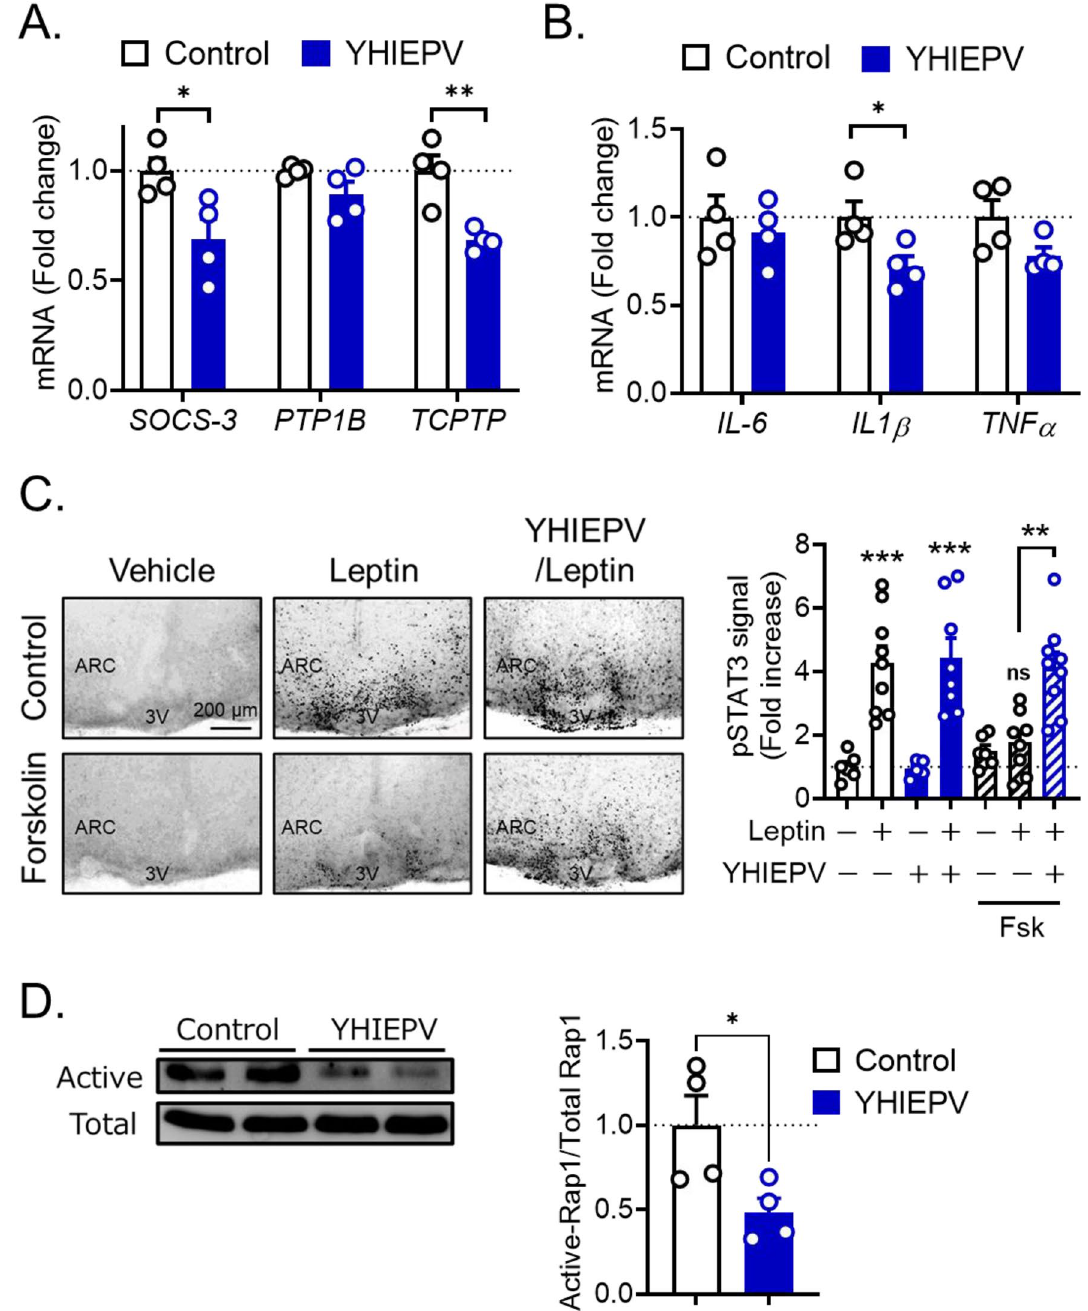
Figure 4. YHIEPV reduces central responses of proinflammatory-related factors and Rap1 activation. ( A , B ) Hypothalamic expression of genes involved in decreased leptin responsiveness in YHIEPV-treated and control C57BL/6 mice. The hypothalamus was collected from 4-month-old HFD-fed male mice after 5 days of the YHIEPV treatment (0.3 mg/kg, p.o.). YHIEPV reduced the hypothalamic mRNA expression of Socs- 3 , Tcptp ( A ), and IL1β ( B ). Mice were fasted for 3 h (from 8 to 11AM) before the collection of hypothalami. ( C ) Effects of YHIEPV on forskolin-induced cellular leptin resistance in organotypic hypothalamus slices. Slices were incubated with forskolin (Fsk, 20 μM) in the presence or absence of YHIEPV (100 μM) for 6 h and then stimulated with leptin (60 nM, 60 min). Leptin-induced pSTAT3 is shown (Left). Scale bar, 200 μm. Quantification of hypothalamic pSTAT3 (Right) (n = 5–9/group) in slices. ( D ) Western blot images (left) and quantification (right) of the amount of the active form of Rap1 in the brains of HFD-induced obese C57BL/6 mice treated with YHIEPV (0.3 mg/kg, p.o., for 5 days) or vehicle (n = 4/group). *p < 0.05, **p < 0.01, ***p < 0.001 for the t -test in ( A ), ( B ), and ( D ) or a one-way ANOVA followed by Tukey’s multiple comparison test in ( C ). All error bars are